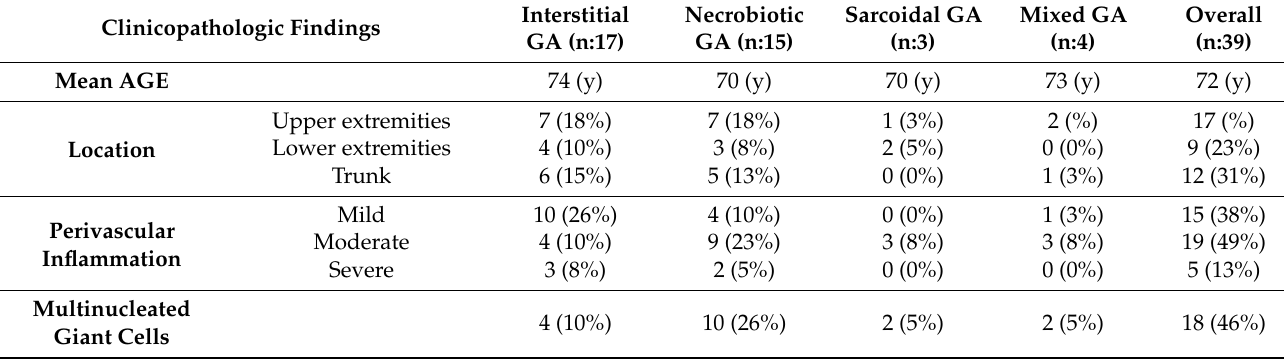
Table 1. Clinicopathologic findings of the MGA